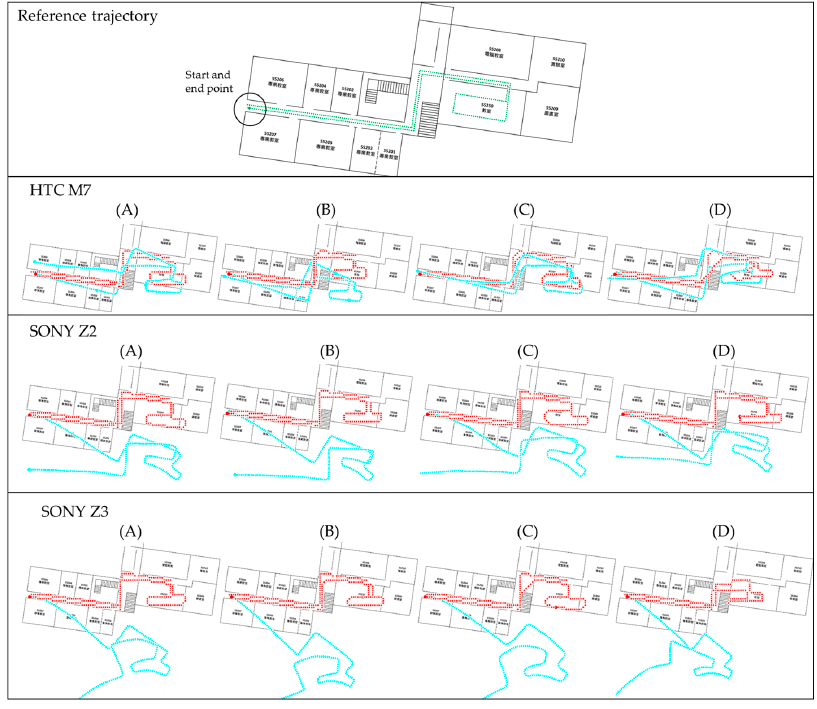
Figure 12. The experimental trajectories at NCKU department building.